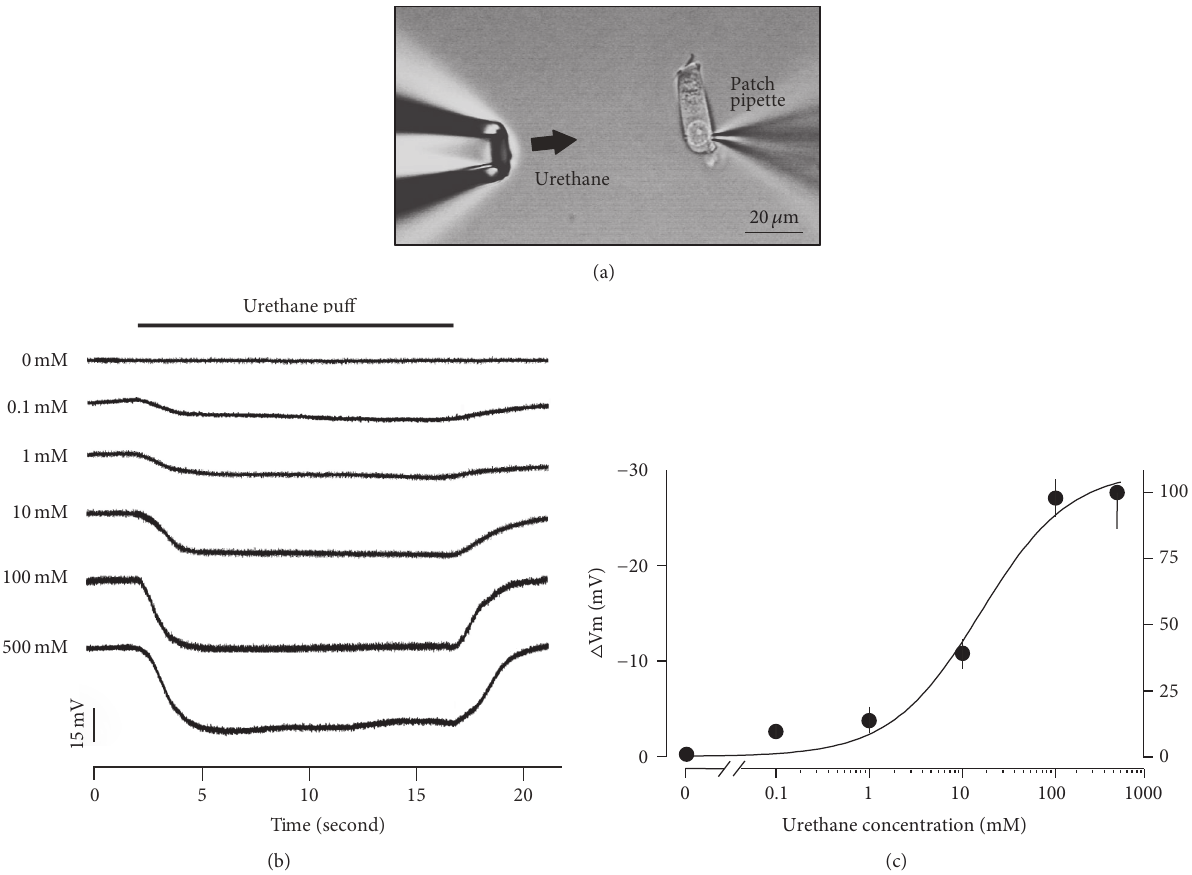
Figure 2: The urethane-induced hyperpolarization of the OHC membrane potential. (a) A photograph showing the experimental setup for the whole-cell patch-clamp recordings. Urethane was delivered via pressure ejection from a micropipette positioned ∼ 50 𝜇 m from the cell. The microphotograph was captured using an upright microscope under bright field illumination. The bar represents 20 𝜇 m. (b) Examples of membrane potentials recorded from OHCs clamped to zero membrane current during the delivery of a urethane puff (0.1 mM, 1mM, 10mM, 100mM, or 500 mM concentration, timing denoted by the horizontal bar) or standard medium (0mM). (c) The dose-response curve of the OHC membrane potential evoked by 0 mM (obtained from 4 cells), 0.1mM (5 cells), 1mM (3 cells), 10mM (5 cells), 100 mM (5 cells), or 500 mM (4 cells) urethane. The data are presented as the mean values; the error bars represent the SD. The values are also normalized to the mean reduction evoked by 500 mM urethane. The smooth curve is the Hill equation with a half-activating concentration of 15.4 mM and a slope of